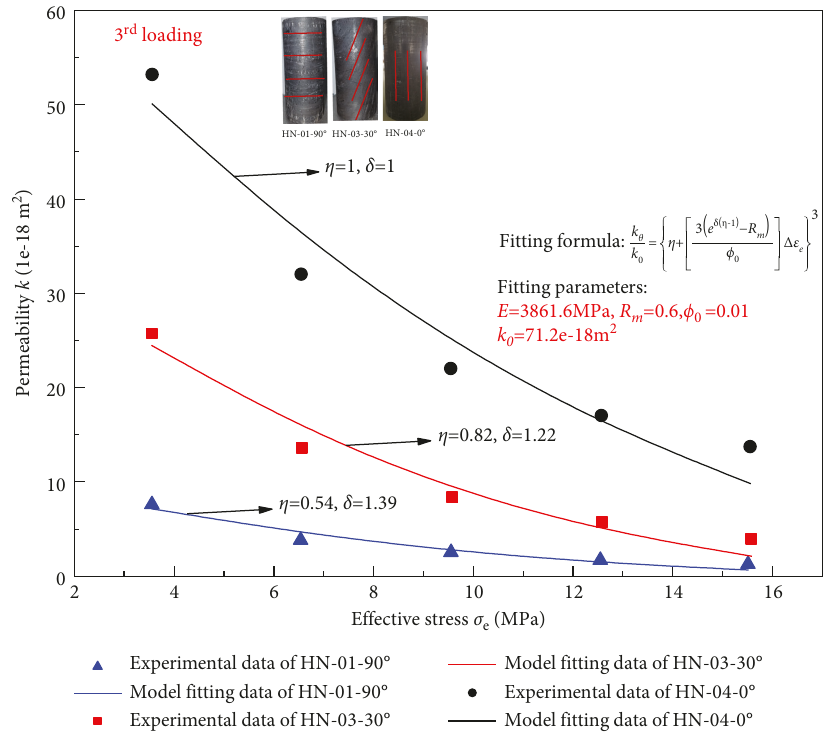
Figure 3: Coal permeability as a function of effective stress. Experimental data are from the 3 rd loading period in Yang et al.